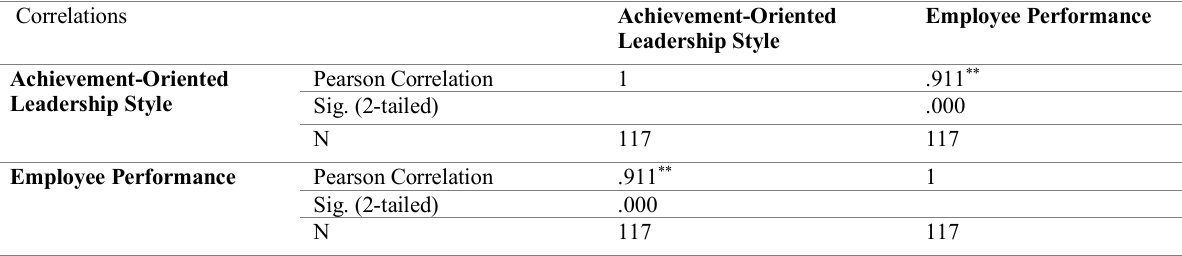
Table 8: Correlation between achievement-oriented leadership style and employee performance